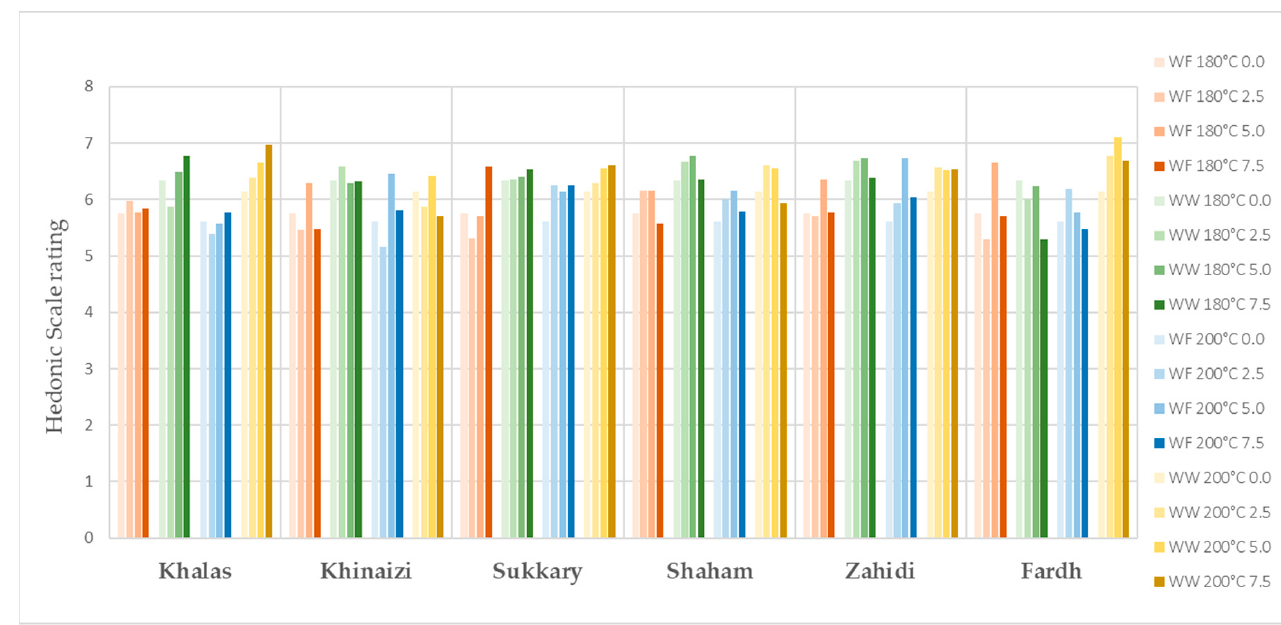
Figure 3. Texture evaluation for date seed composite cookies.